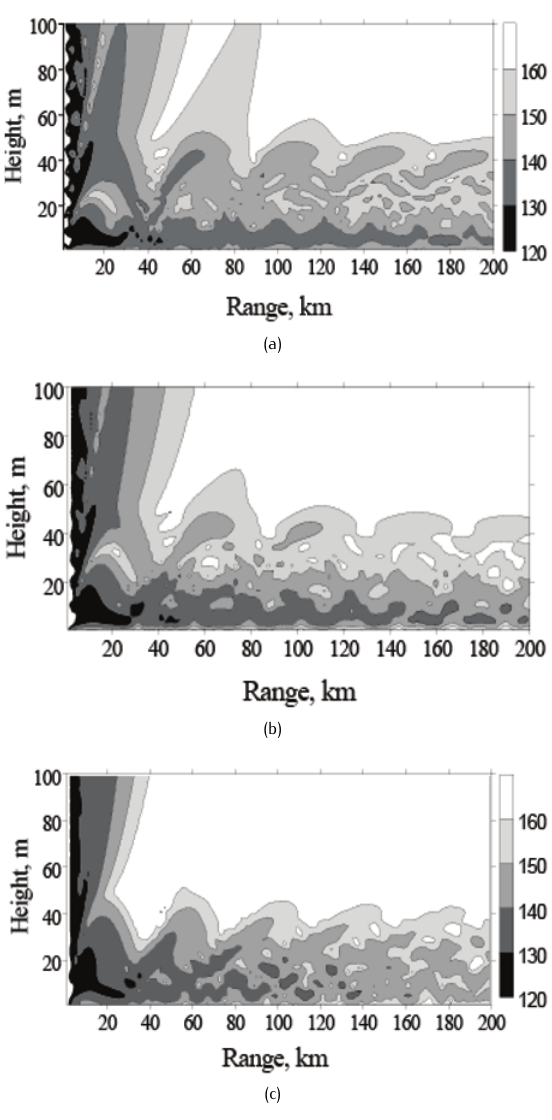
Figure 5. Path loss under surface duct conditions: (a) smooth sea Fig. 5 Path loss under surface duct conditions: (a) smooth sea surface; (b) phase- surface; (b) phase- corrected Ament RRF with u =7 m/s; (c) phase-corrected Ament RRF with u =10 m/s. corrected Ament RRF with u 10 = 10 10 7 m/s; (c) phase-corrected Ament RRF with u 10 = 10 m/s.